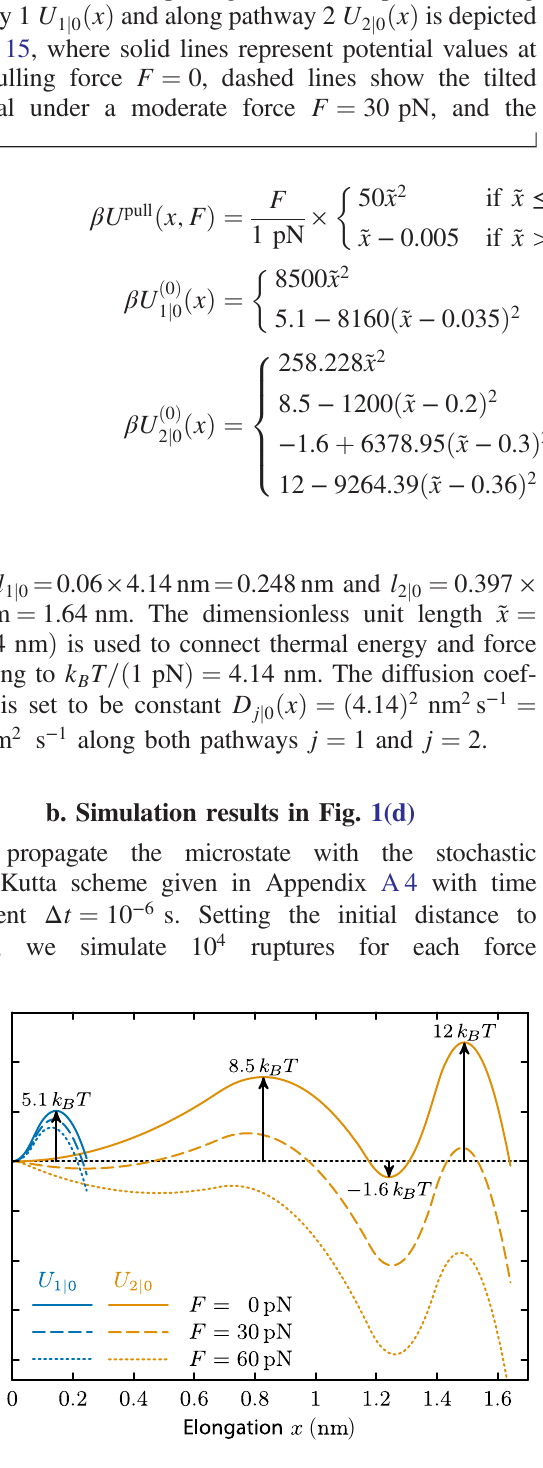
FIG. 15. Catch-bond free-energy landscape. The local potential 0 Þ x Þ ¼ U ð is set to U ð x Þ þ U load ð F; x Þ . The precise form of j j 0 ð j j 0 U 1 and U 2 is given in Eq. (E1). For a biophysical setting j 0 j 0 underpinned by the potential, see Fig. 5(a) in Ref. [35] [see also Fig. 1(d)